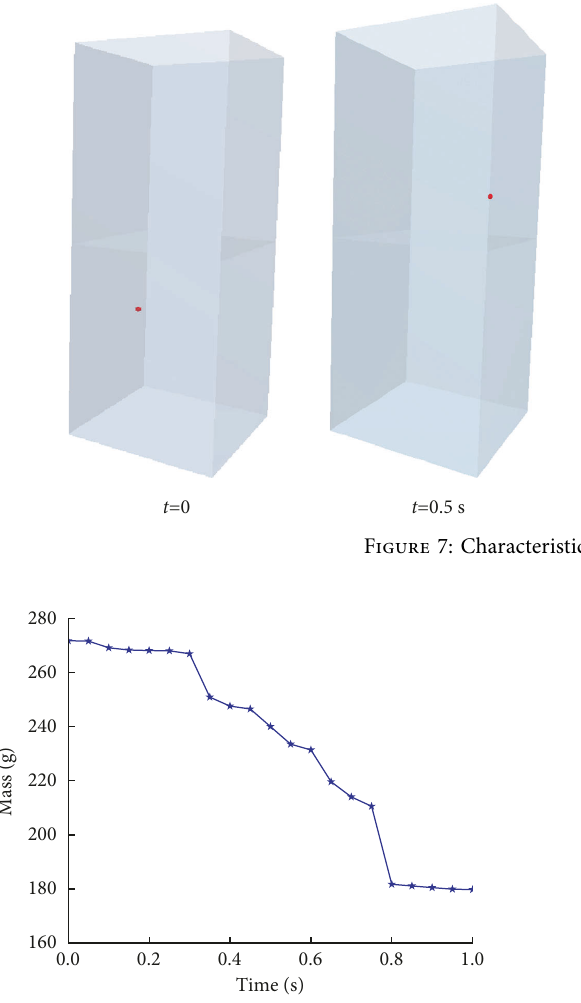
Figure 8: Broken line diagram of residual mass variation with numerical simulation time.